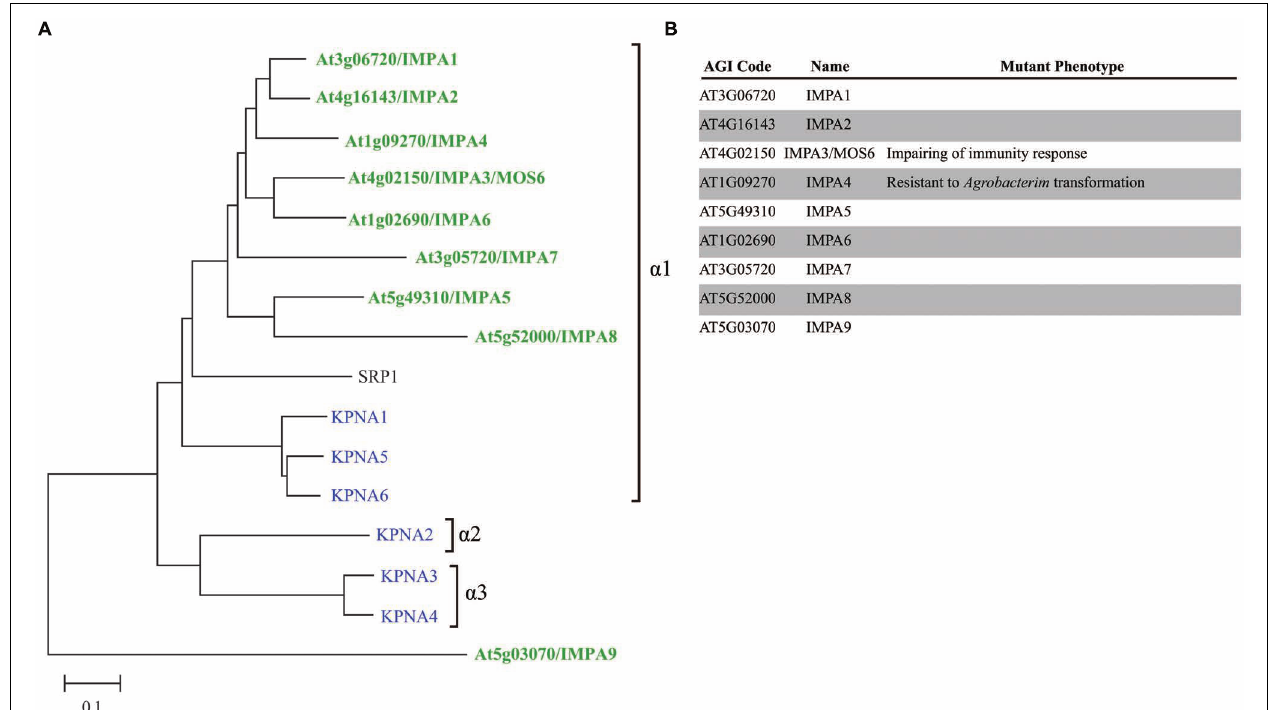
FIGURE 2 | Comparison of importin α family proteins in Arabidopsis , human, and yeast. (A) Phylogenetic tree of importin α family in Arabidopsis (green), human (blue), and yeast (black) constructed using the neighbor joining method. (B) Arabidopsis importin α family